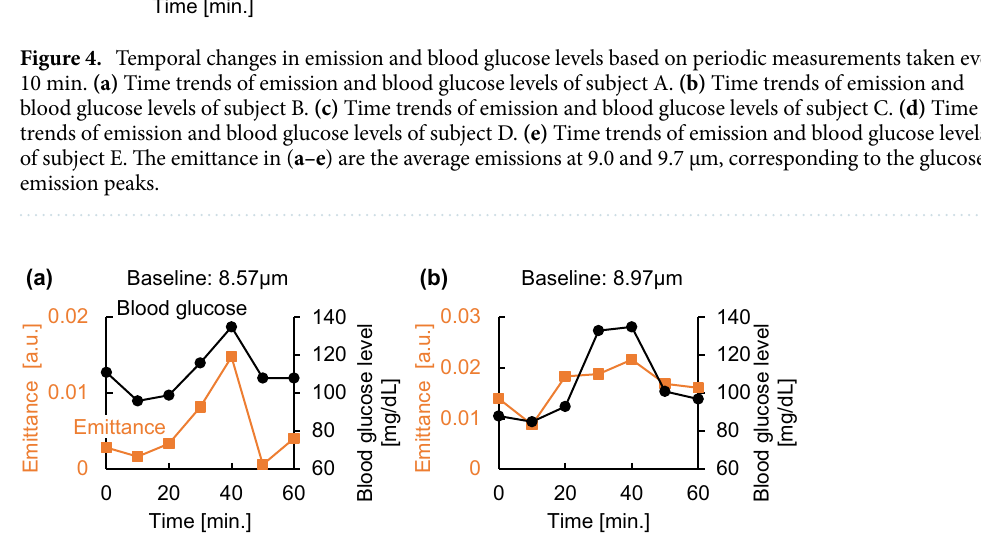
Figure 5. Optimizing the correction wavelength in the measurements of subjects D and E. (a) Results for subject D (corrected wavelength of 8.57 µm). (b) Result for subject E (corrected wavelength 8.97